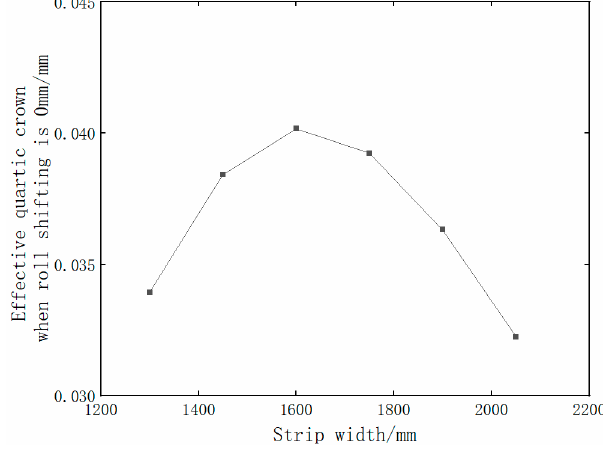
Figure 13. Adjustment ability of effective quartic crown of MVCplus for strips with different widths.